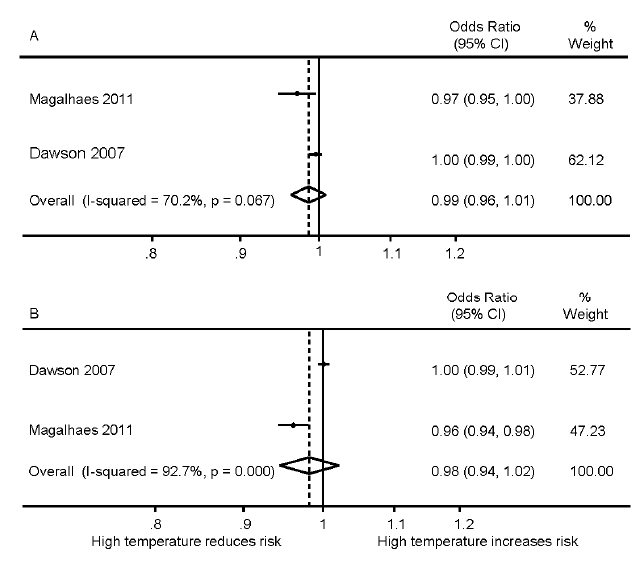
Figure 3. Meta-analysis of ambient temperature and ischemic stroke: ( A ) daily minimum temperature; ( B ) daily maximum ( B ) daily maximum temperature.